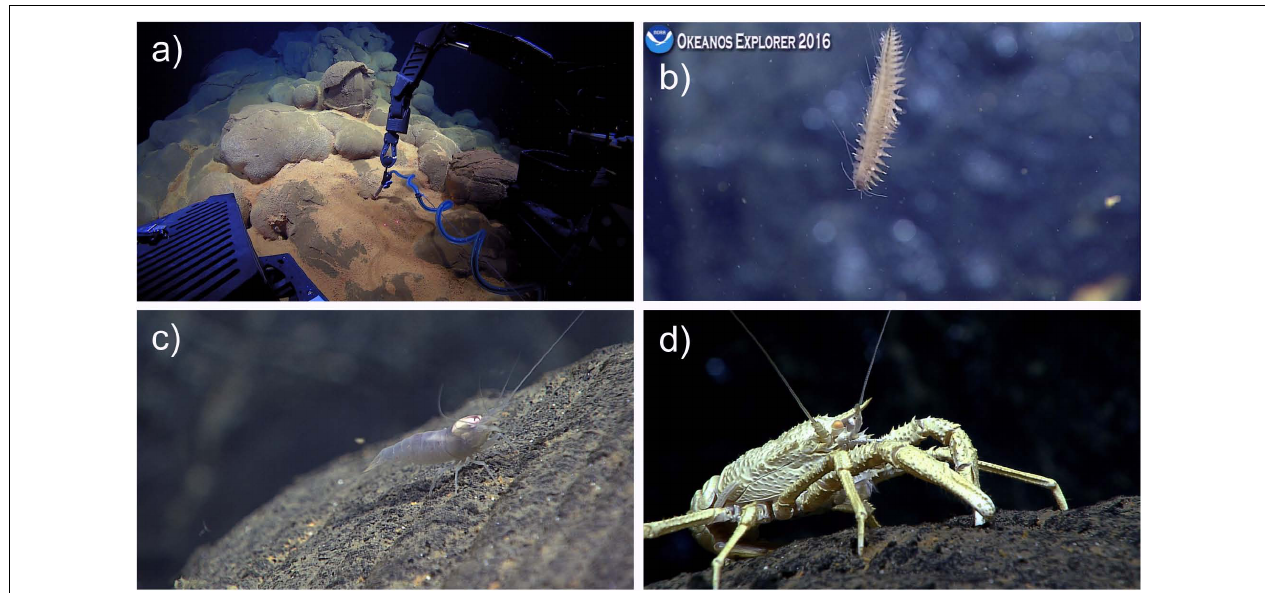
FIGURE 9 | Images of hydrothermal vent animals observed on the new lavas during ROV Deep Discoverer dive EX1605L1-09 on 29–30 April 2016. Numbers in parentheses are time of photo in GMT and horizontal scale. (A) ROV manipulator arm measuring temperature of 7.0 ◦ C (ambient = 1.65 ◦ C) in an area of very diffuse venting (02:17:21, ∼ 5 m). (B) One of many polychaetes seen swimming above the bottom (23:03:48, ∼ 6 cm). (C) Shrimp (00:11:20, ∼ 3 cm). (D) Squat lobster (00:24:51, ∼ 5